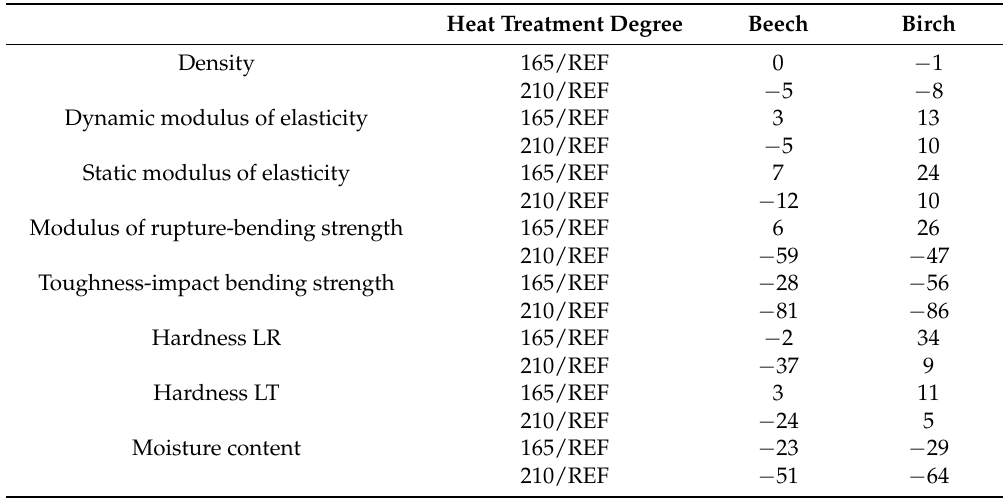
Table 5. Changes in Wood Property of Heat-treated Wood in Comparison to the Reference (untreated) Wood in